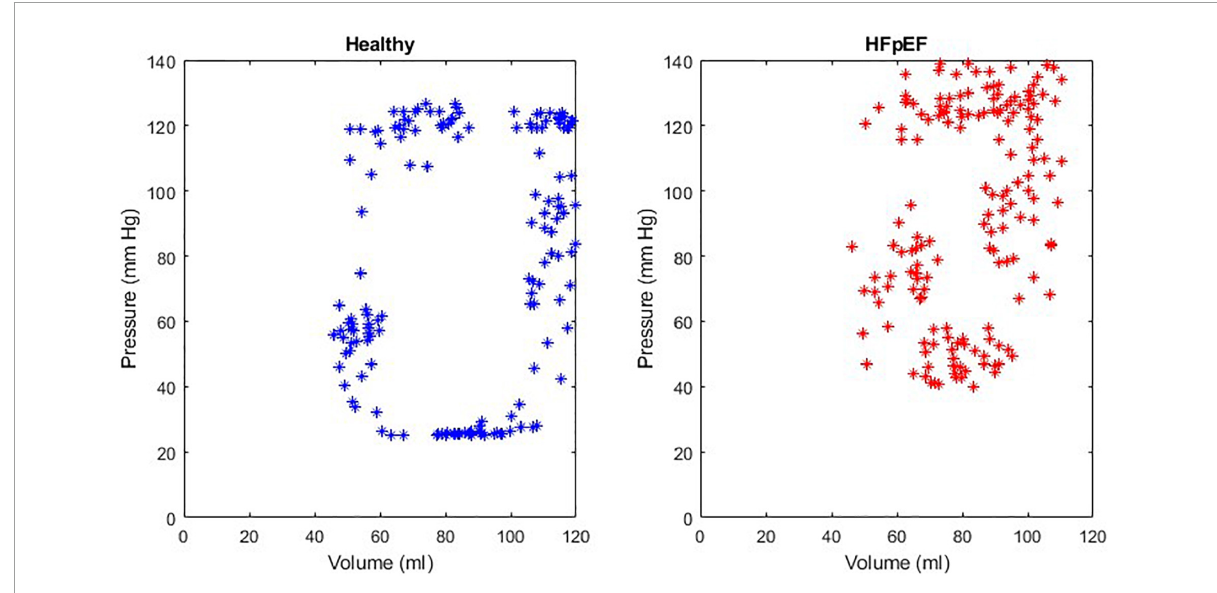
FIGURE6 An example of a healthy PV loop and HFpEF PV loop generated from data recorded on the MCL Mk II.